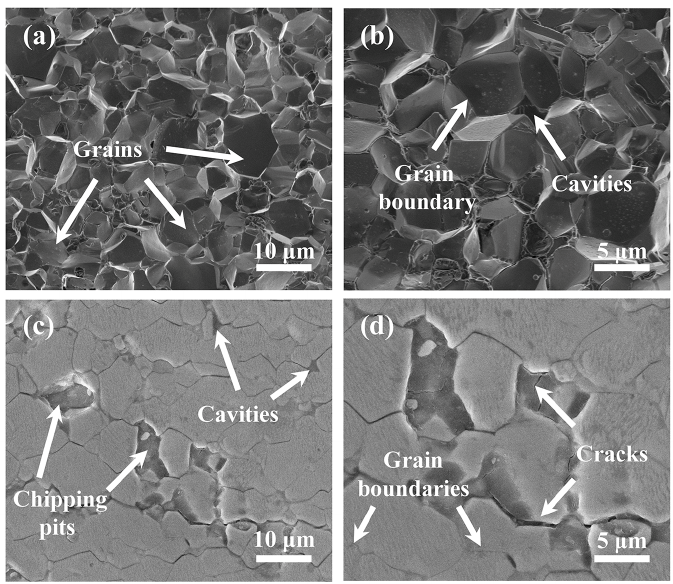
Figure 12. ( a,b ) SEM images of the internal organization of NdFeB; ( c,d ) SEM images of the pol- ished NdFeB surface. NdFeB